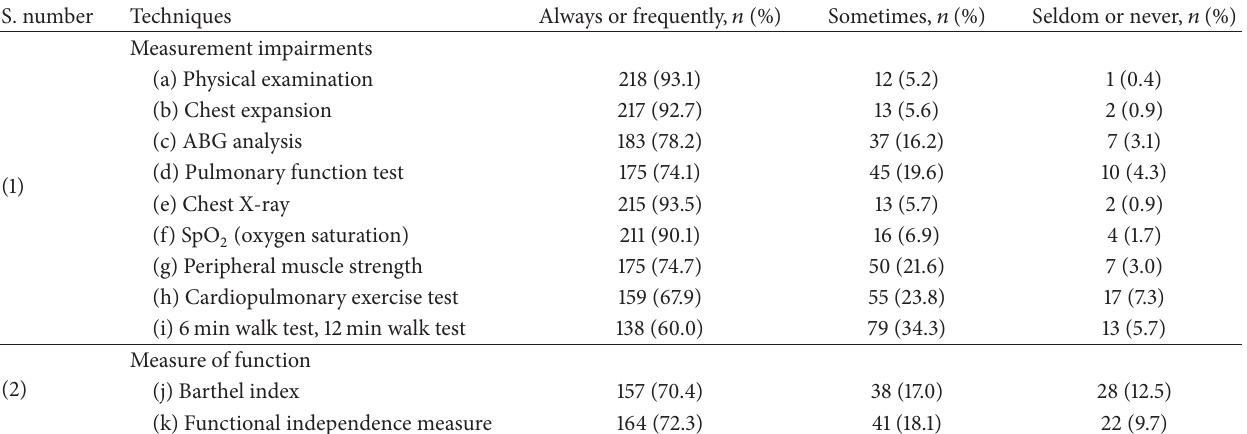
Table 2: Preoperative assessment for thoracic surgery patients.